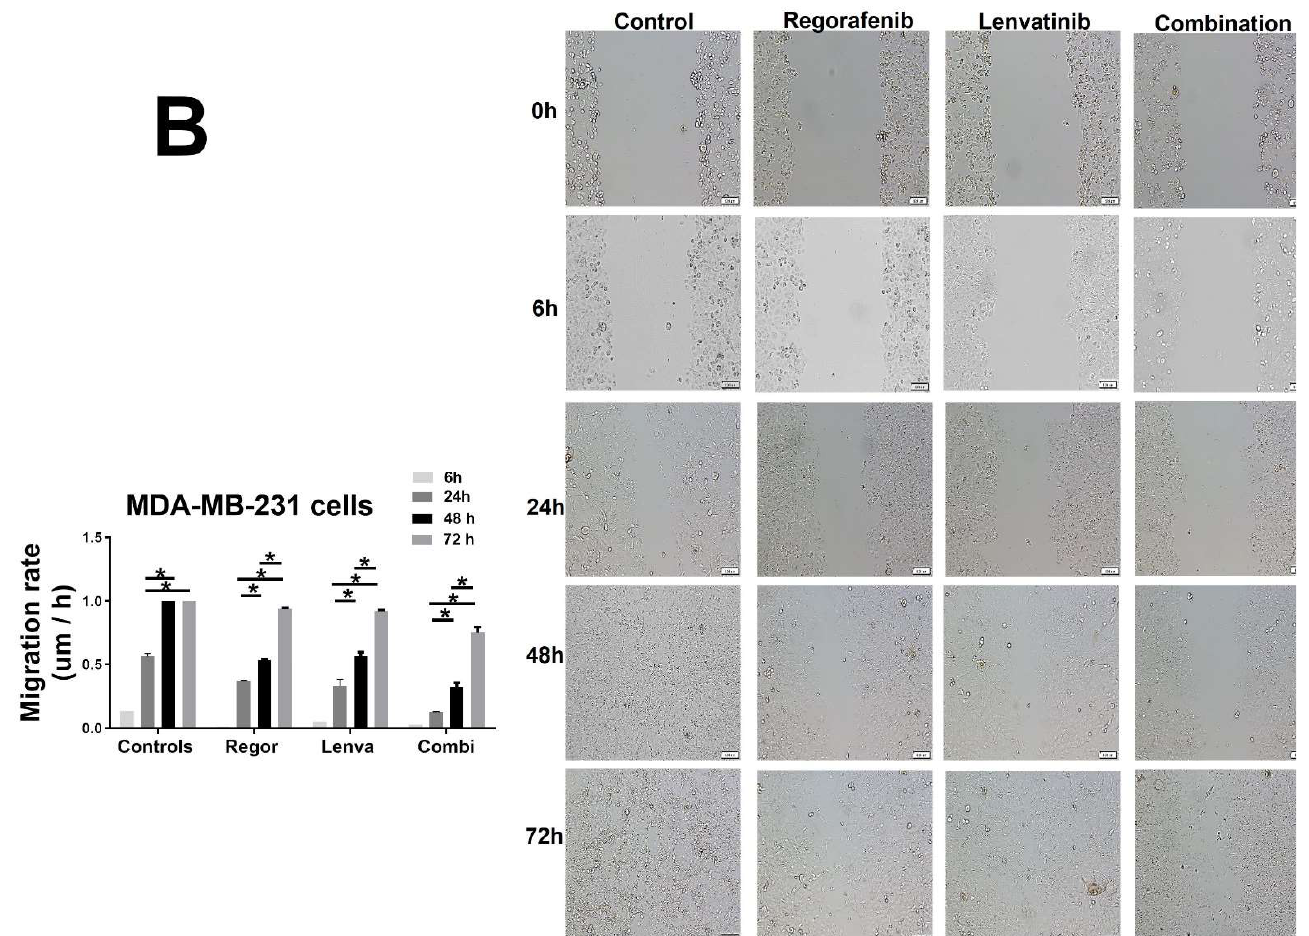
Figure 3. Effect of Regorafenib and Lenvatinib on cell migration. A scratch test was used to assess ( A ) MCF-7 and ( B ) MDMBA cells migration and the width of the scratch was noted at the pre-defined time points of 6, 24, and 48 h. The untreated control cells showed significant cellular migration, while treatment with Regorafenib and Lenvatinib alone or in combination prevented the migration of MCF-7 and MDMBA cells, confirming the anti-metastatic potential of these drugs. * statistically significant from the control cells, p -value < 0.05.